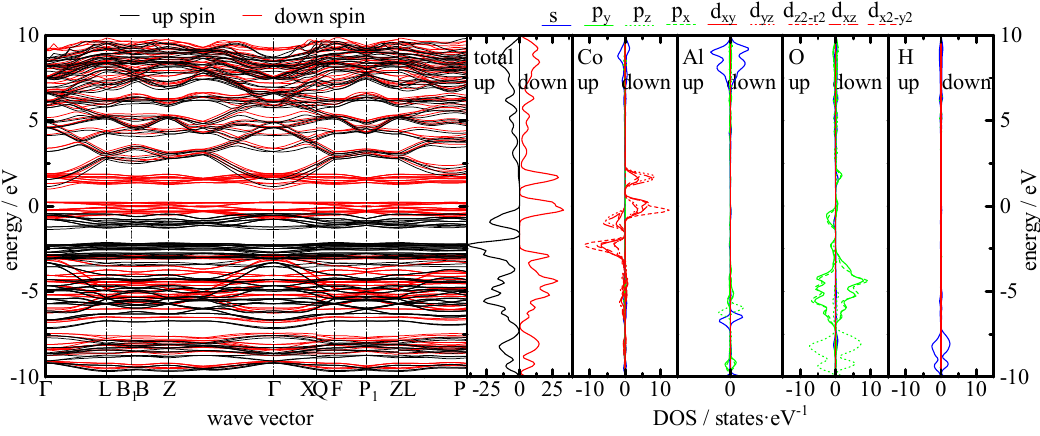
Figure 12. Band structure, total DOS, and partial DOS for each element of CoAl LDH.